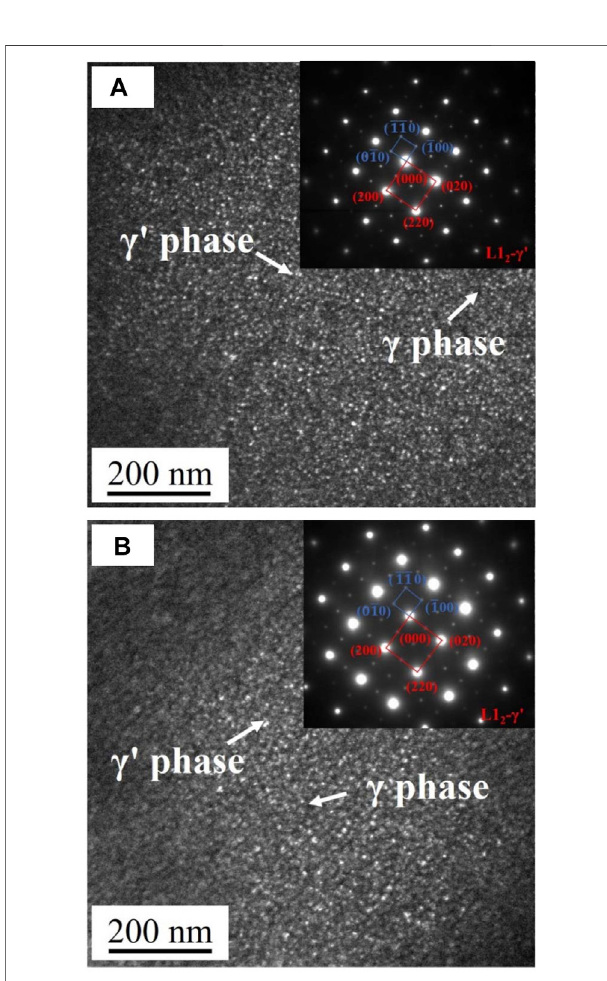
FIGURE 1 | Hot-rolled TEM micrographs of Co-Ni-Al-Ti-based superalloys: (A) 2Cr, (B) 2Mo.